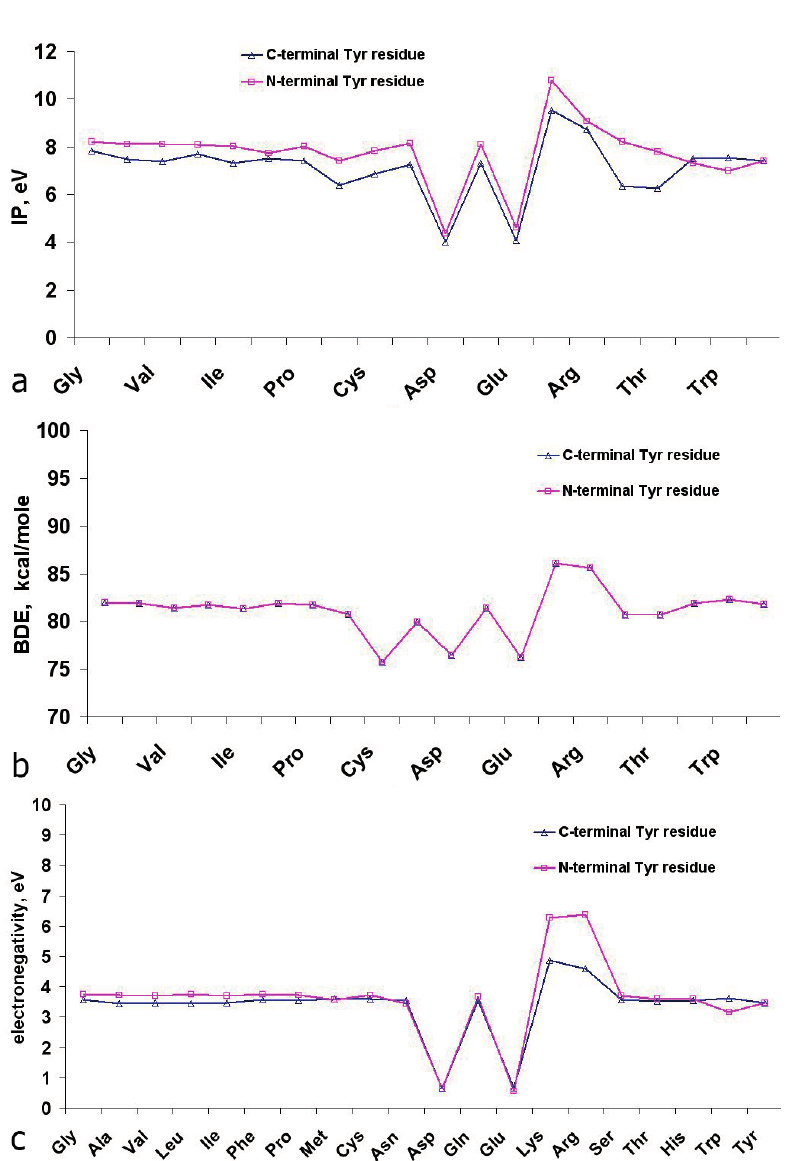
Figure 12. Ionization potential IPe ( a ), bond dissociation energy of phenolic O–H bond ( b ) and electronegativity ( c ) of N- and C-terminal tyrosine dipeptides in gas phase at 298